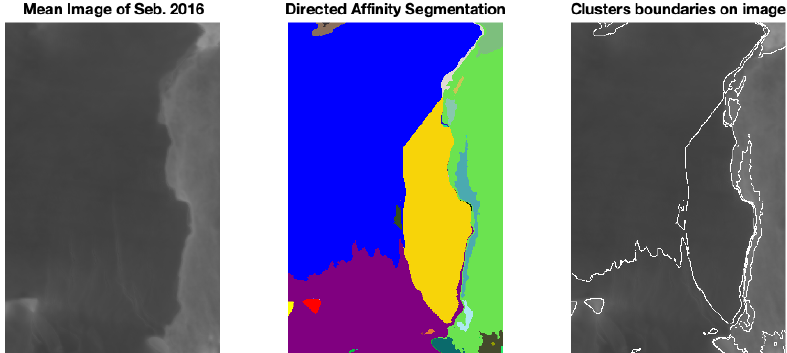
Figure B5. The mean image and the directed affinity partitioning as of September 2016. Raw images sourced from Scambos et al. (1996).